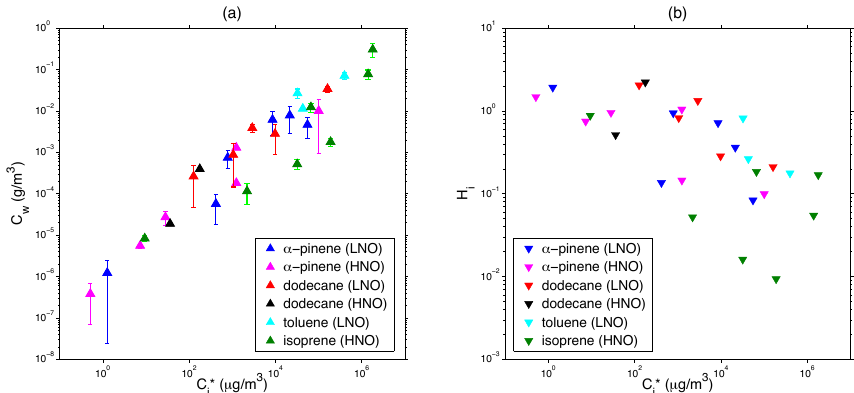
Figure 5. Inferred total amount of (a) equivalent absorbing organic mass on the chamber wall, C w (gm − 3 ), and (b) dimensionless Henry’s law constants, H i , as a function of saturation concentration, C ∗ (µgm − 3 ). Estimated vapor pressures of organic compounds studied here are i obtained from the average of predictions from the two group contribution methods, “SIMPOL.1” (Pankow and Asher, 2008) and “EVAP- ORATION” (Compernolle et al., 2011). The uncertainty bars give the upper and lower limits of C w values derived from Eq. (12), together with Eqs. (16) and (17), when either “EVAPORATION” or “SIMPOL.1” is used to estimate vapor